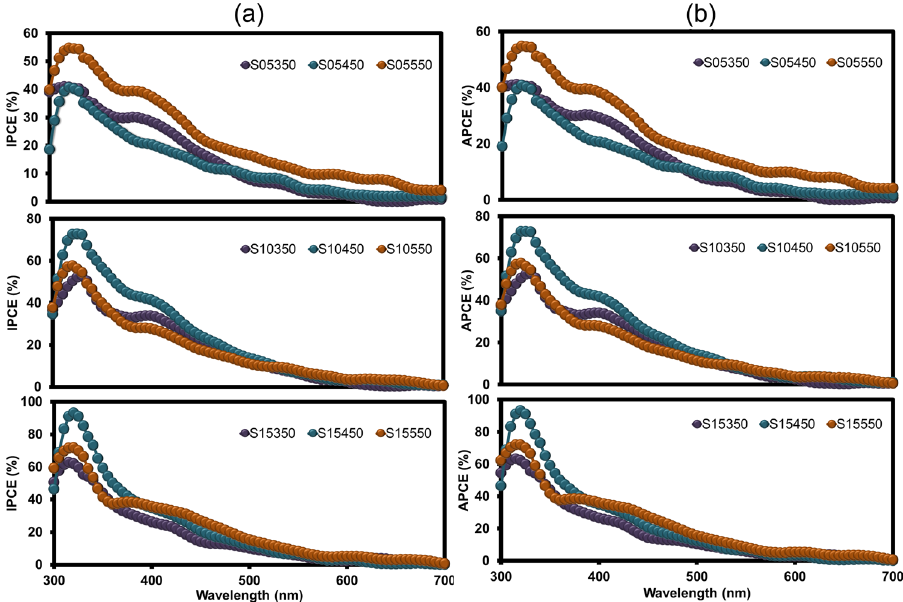
Figure 6. ( a ) Incident photon-to-current conversion efficiency (IPCE) plot of FTO/CuO/CuBi 2 O 4 fabricated with different number of coating layers and at different annealing temperatures. IPCE was measured at a potential of − 0.6 V in a 0.1 M Na 2 SO 4 and calculated using the Eq. (9); and ( b ) Absorbed photo-to-current density (APCE) plot obtained from IPCE data and absorbance values (Eq.